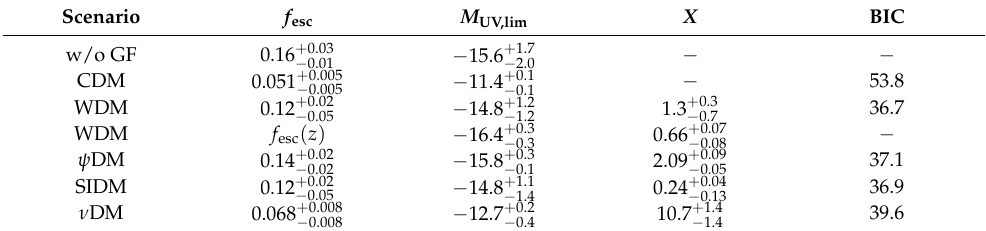
is the limiting UV